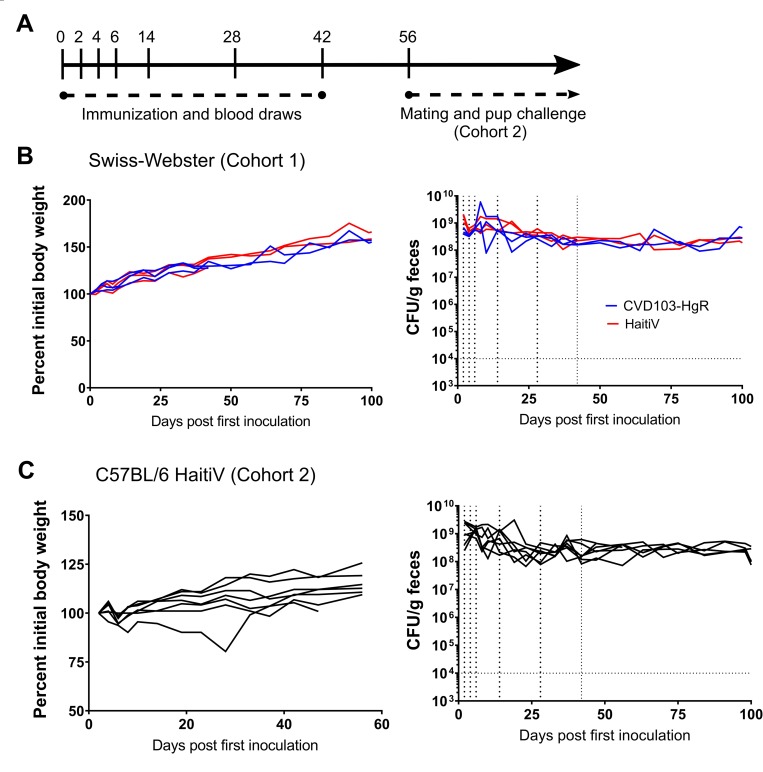
Fecal vaccine shedding and weight of adult GF mice after oral administration of live attenuated cholera vaccines.(A): Schematic of vaccination regime–note that only cohort 2 was used for protection studies. (B and C): Bodyweight (left) and fecal CFU shedding of HaitiV (right) for cohort 1 and 2 respectively. Curves that stop before day 100 represent mice that were lost during the study due to injury resulting from oral gavage or bleeding.